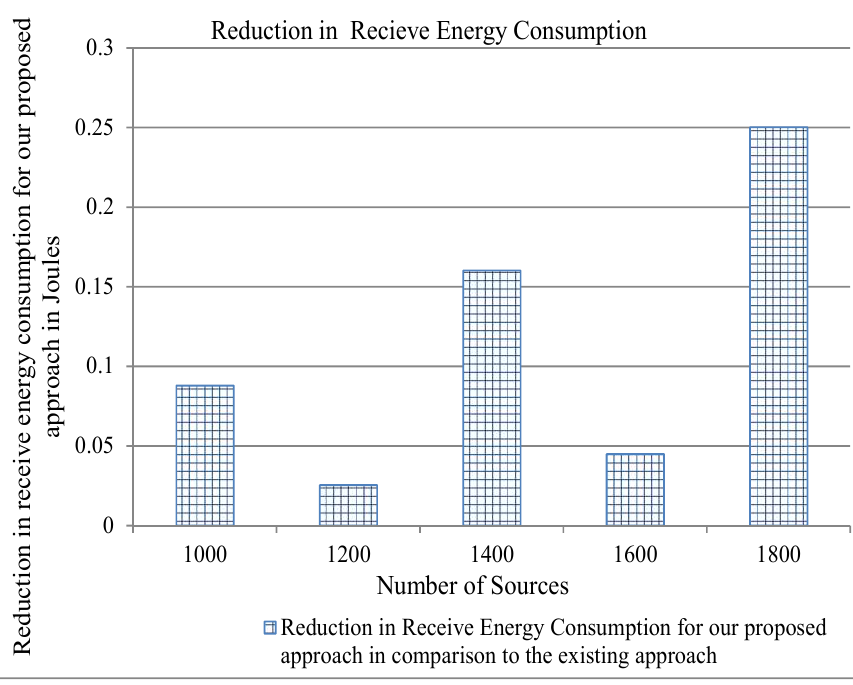
Figure 8. Reduction in Receive Energy for our proposed approach in comparison to the existing for two cache